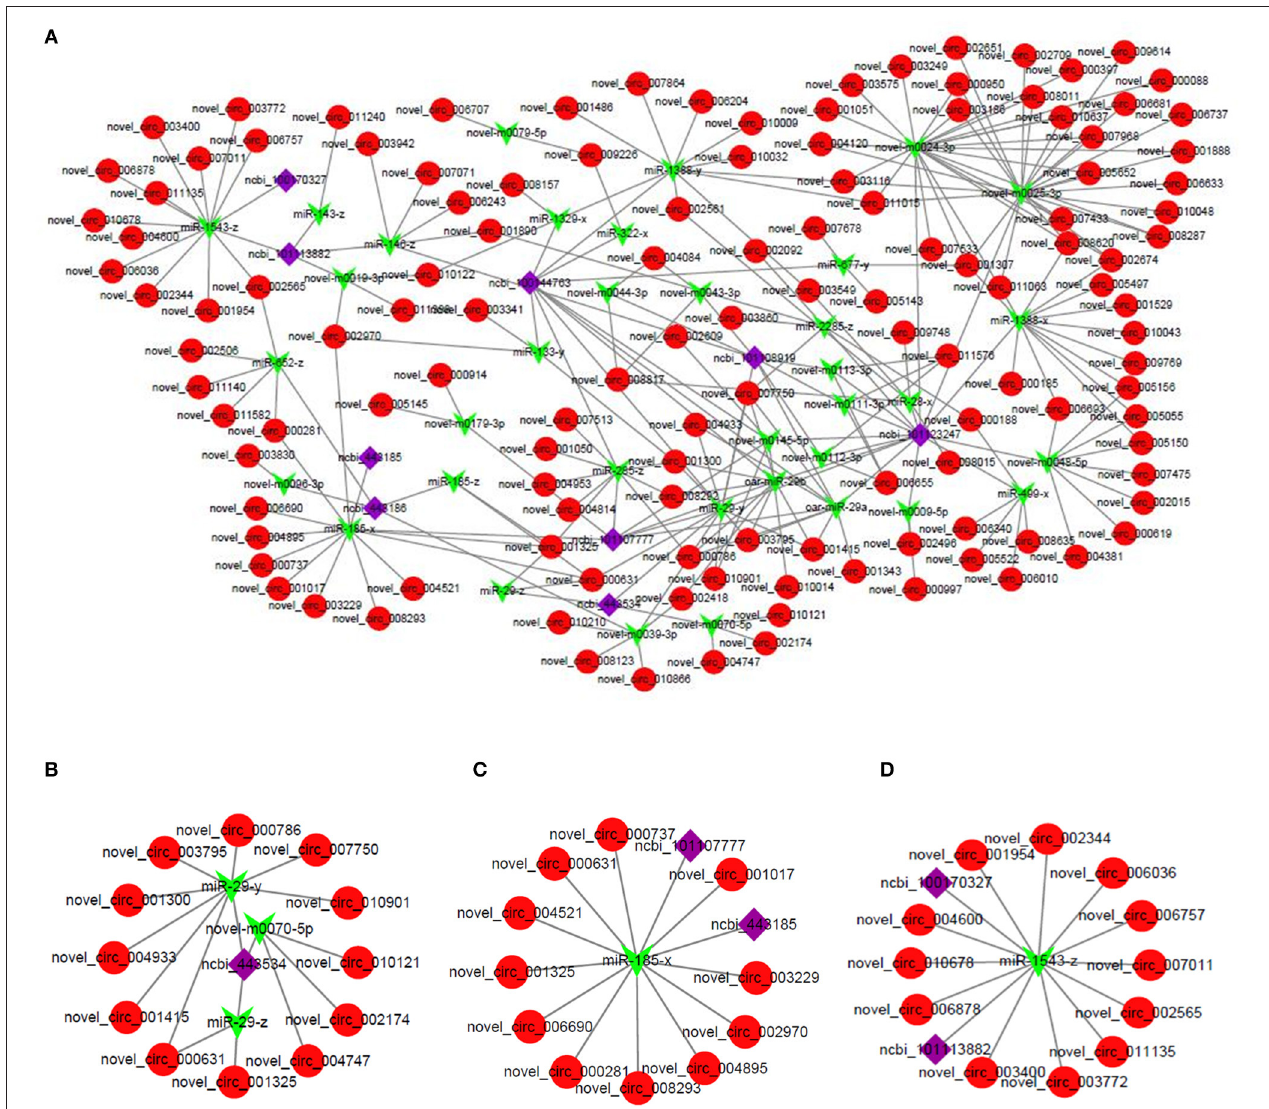
FIGURE 5 | (A) The circRNA–miRNA–mRNA interaction network in LT muscle of Tibetan sheep. (B) Representative subnetwork of LEP . (C) Representative subnetwork of SCD . (D) Representative subnetwork of FASN . Red circles represent circRNAs, green V shape represents miRNAs, and purple squares represent